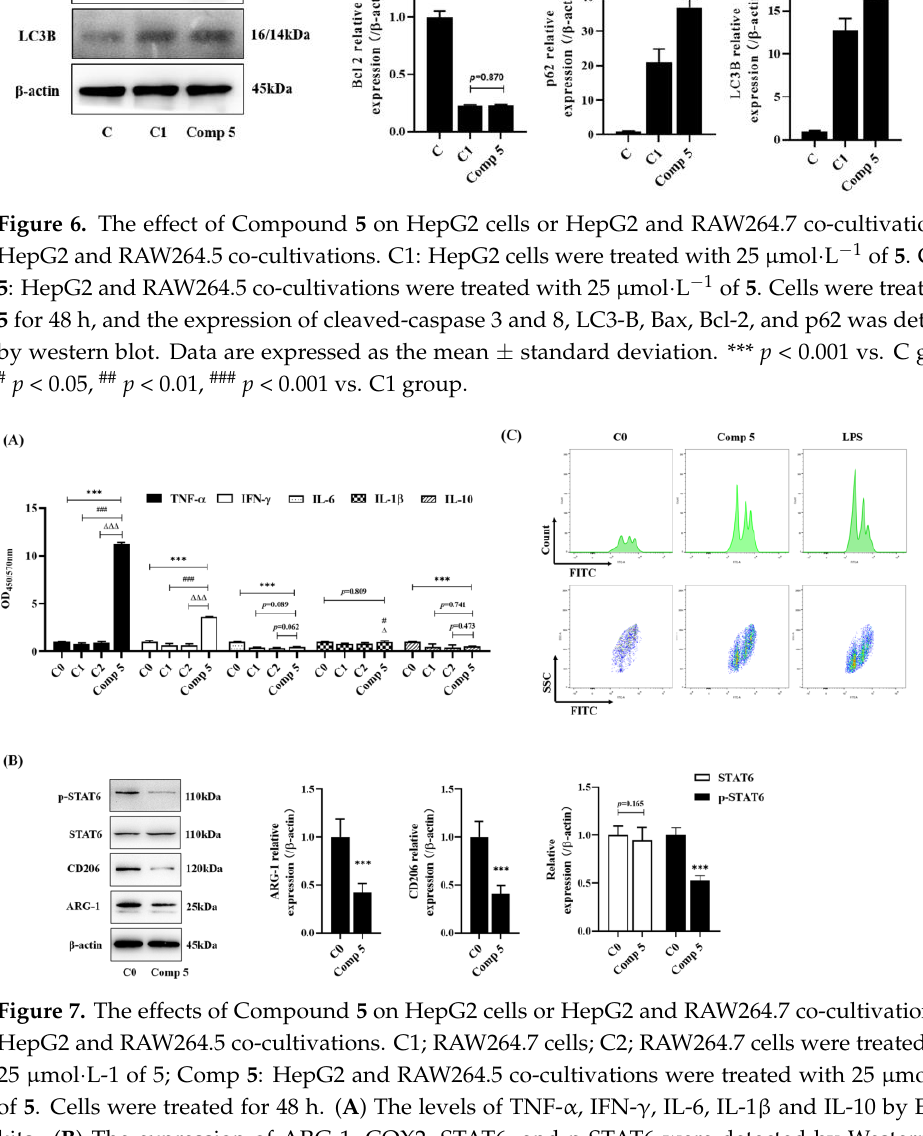
not. RAW264.7 cells were treated with 1 µ g/mL LPS only (LPS). The cells were analyzed by Flow cytometry. Data are expressed as mean ± standard deviation. *** p < 0.001 vs. C0 group; # p < 0.05, ### p < 0.001 vs. C1 group; ∆ p < 0.05, ∆∆∆ p < 0.001 vs. C2